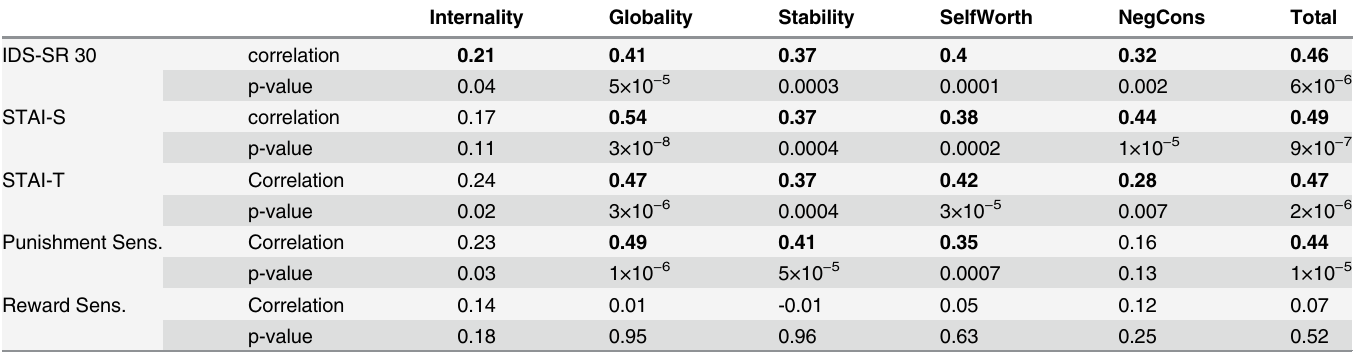
Table 4. Correlation between total score and subscales with external measures of depression (IDS-SR 30), state and trait anxiety (STAI-S and STAI-T) and reward and punishment sensitivity. Total CSQ-SF-D scores are highly significantly correlated with measures of anxiety, depression and pun- ishment sensitivity, but not reward sensitivity. Boldface indicates significant Pearson ’ s linear correlations.